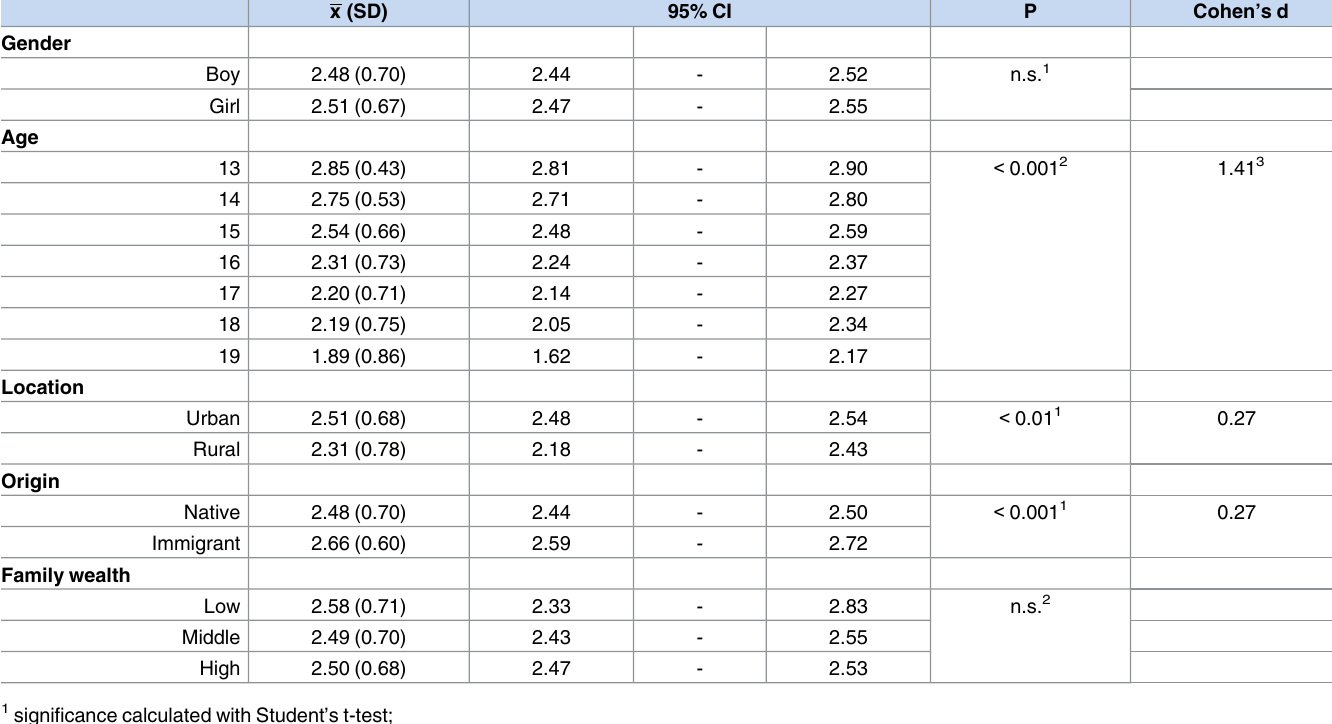
significance calculated with the ANOVA test; 3 Magnitude of the effect between 13 and 19 years of